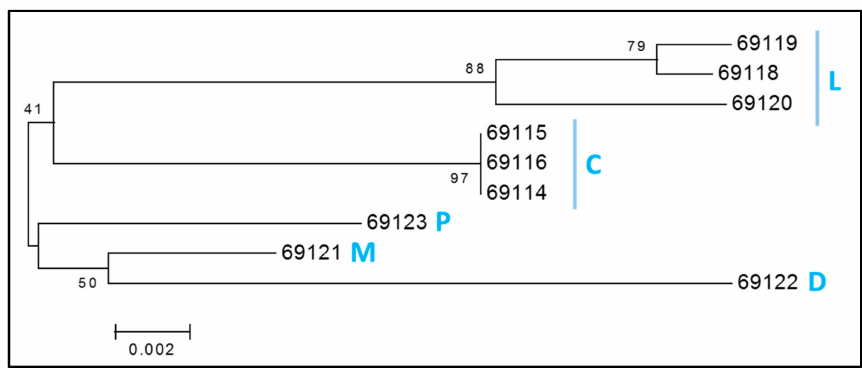
Figure 5. Consensus neighbor-joining tree of mitochondrial haplogroups (HGs) of 9 ENHs. Blue letters represent five identified HGs. The tree was drawn based on 1000 bootstrap replicates, values shown as percentages at branch points. HGs are denoted by letters according to previous nomenclature [34].